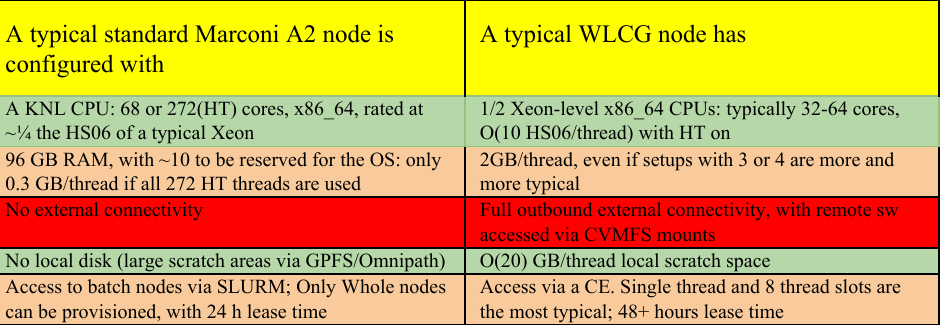
Table 1. Differences between a WLCG node and a standard Marconi A2 computing ​